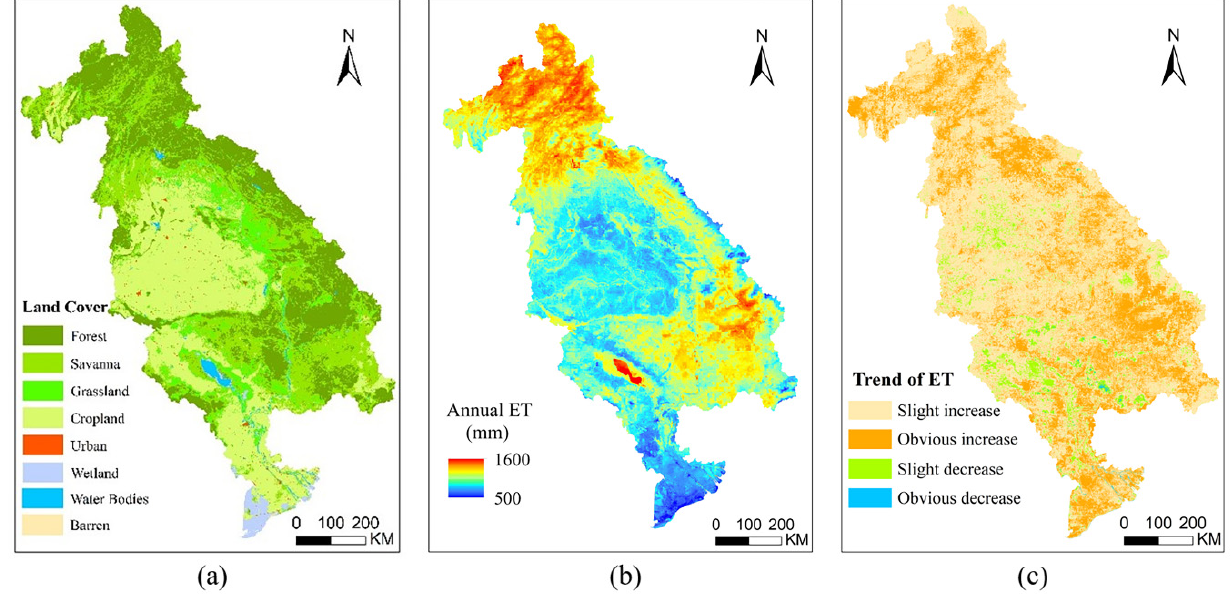
Figure 5. ( a ) Spatial distribution of land use in the Lower Mekong River Basin from 2008 to 2017; ( b ) Spatial distribution of average ET from 2008 to 2017; ( c ) Sen + MK trend analysis of spatial and temporal variability of ET in the Lower Mekong River Basin from 2008 to 2017.